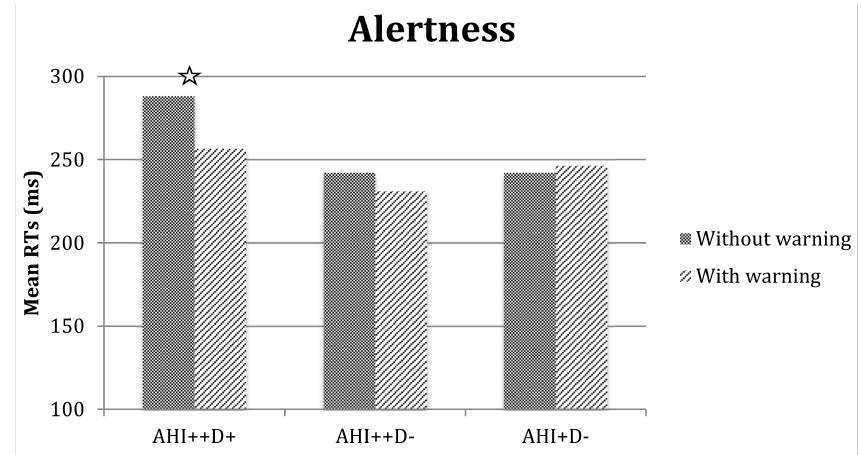
Figure 2. Alertness reaction times in no-warning and warning conditions for three groups of OSA patients. Legend: Stars indicate significant di ff